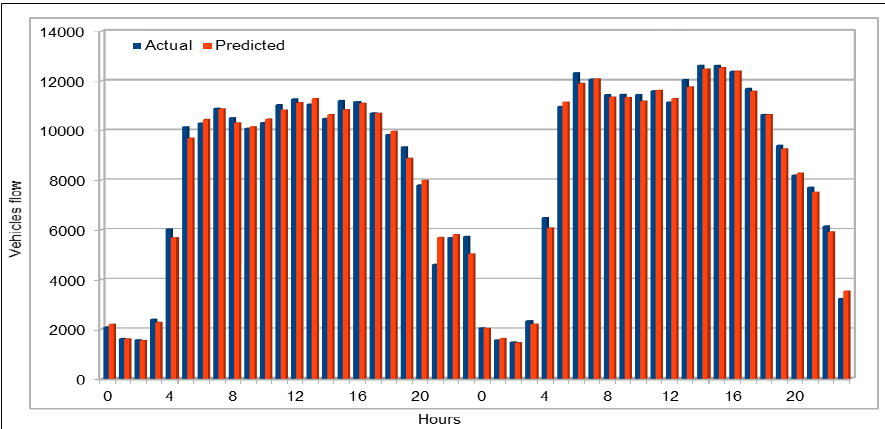
Figure 7. Traffic flow: Actual and predicted values (total of all VDS) (48